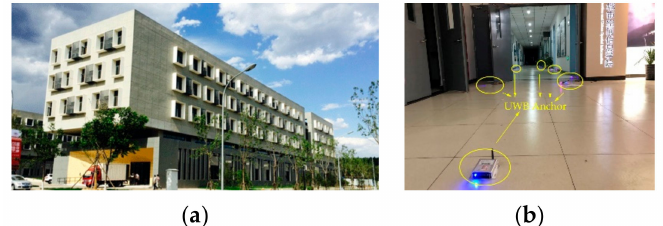
Figure 7. Pedestrian indoor positioning experiment scene. ( a ) Outside scene of the building ( b ) The scene of the corridor.